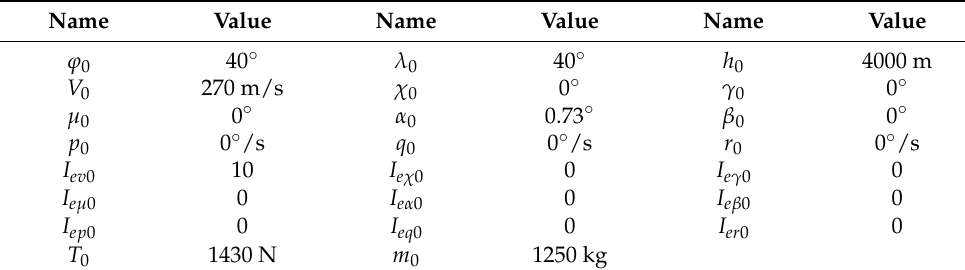
Table 7. Initial state settings of the morphing aircraft and the integrators in Section 5.3.